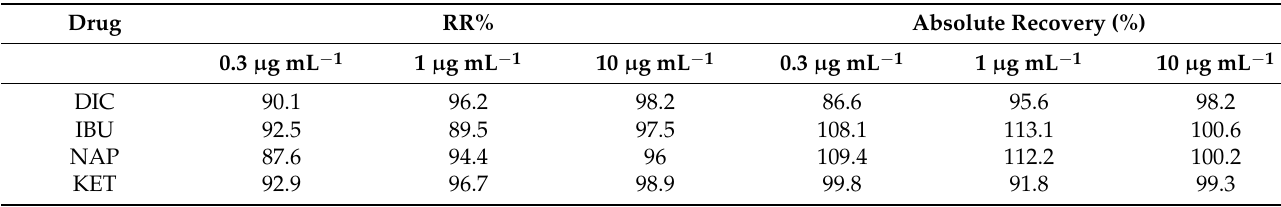
Table 5. Extraction efficiency parameters of proposed